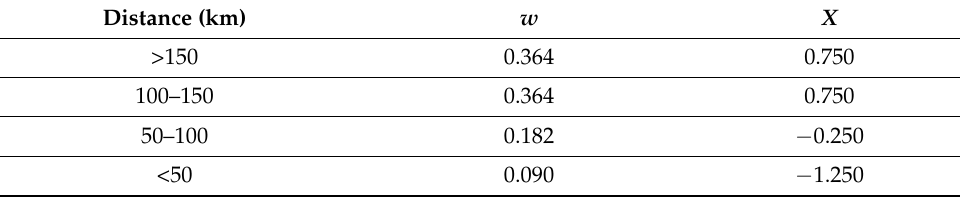
Table 7. Ranking of the categories of distance to the container’s final destination according to retention time.